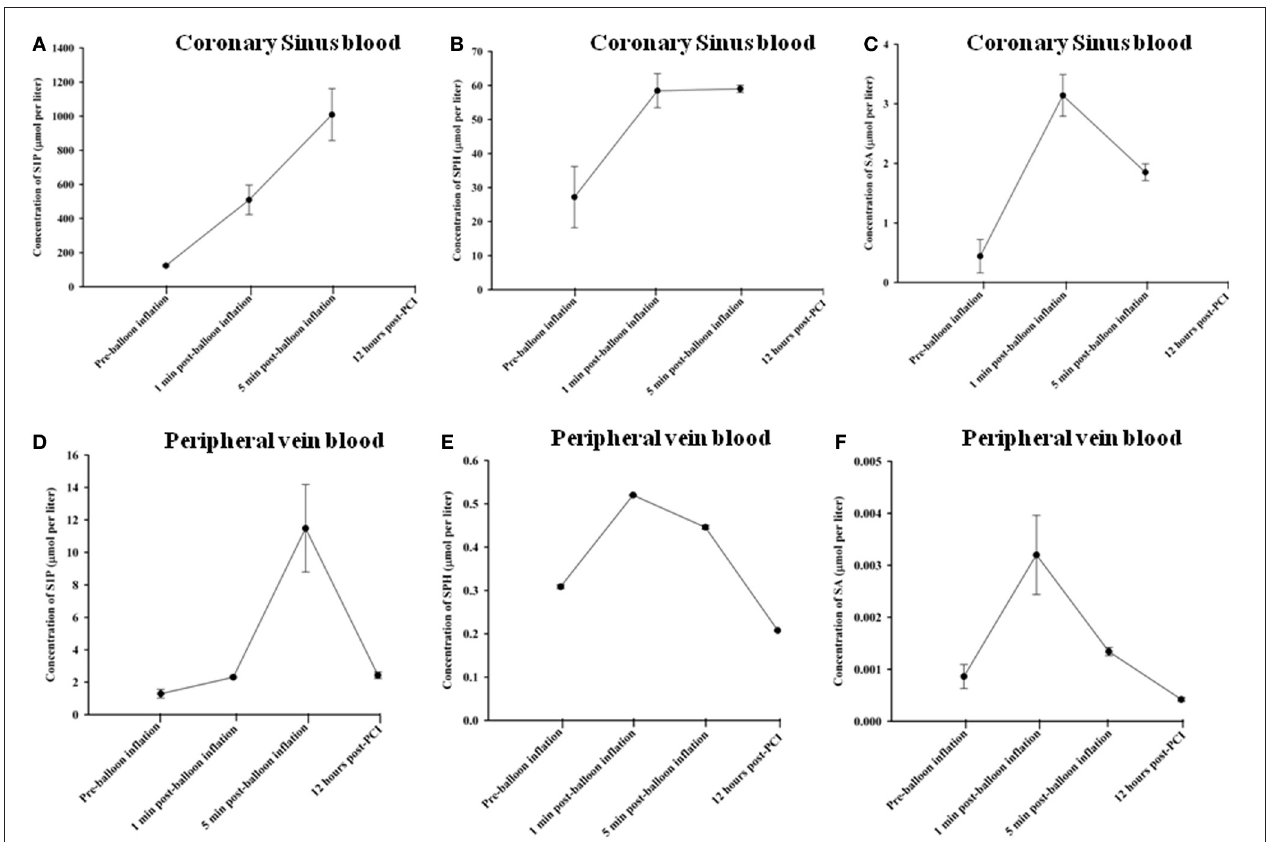
FIGURE 2 | Changes in sphingolipid concentrations in coronary sinus blood: S1P (A); SPH (B); and SA (C) and comparative concentrations in peripheral blood for S1P (D); SPH (E); and SA (F), at different time course points following balloon